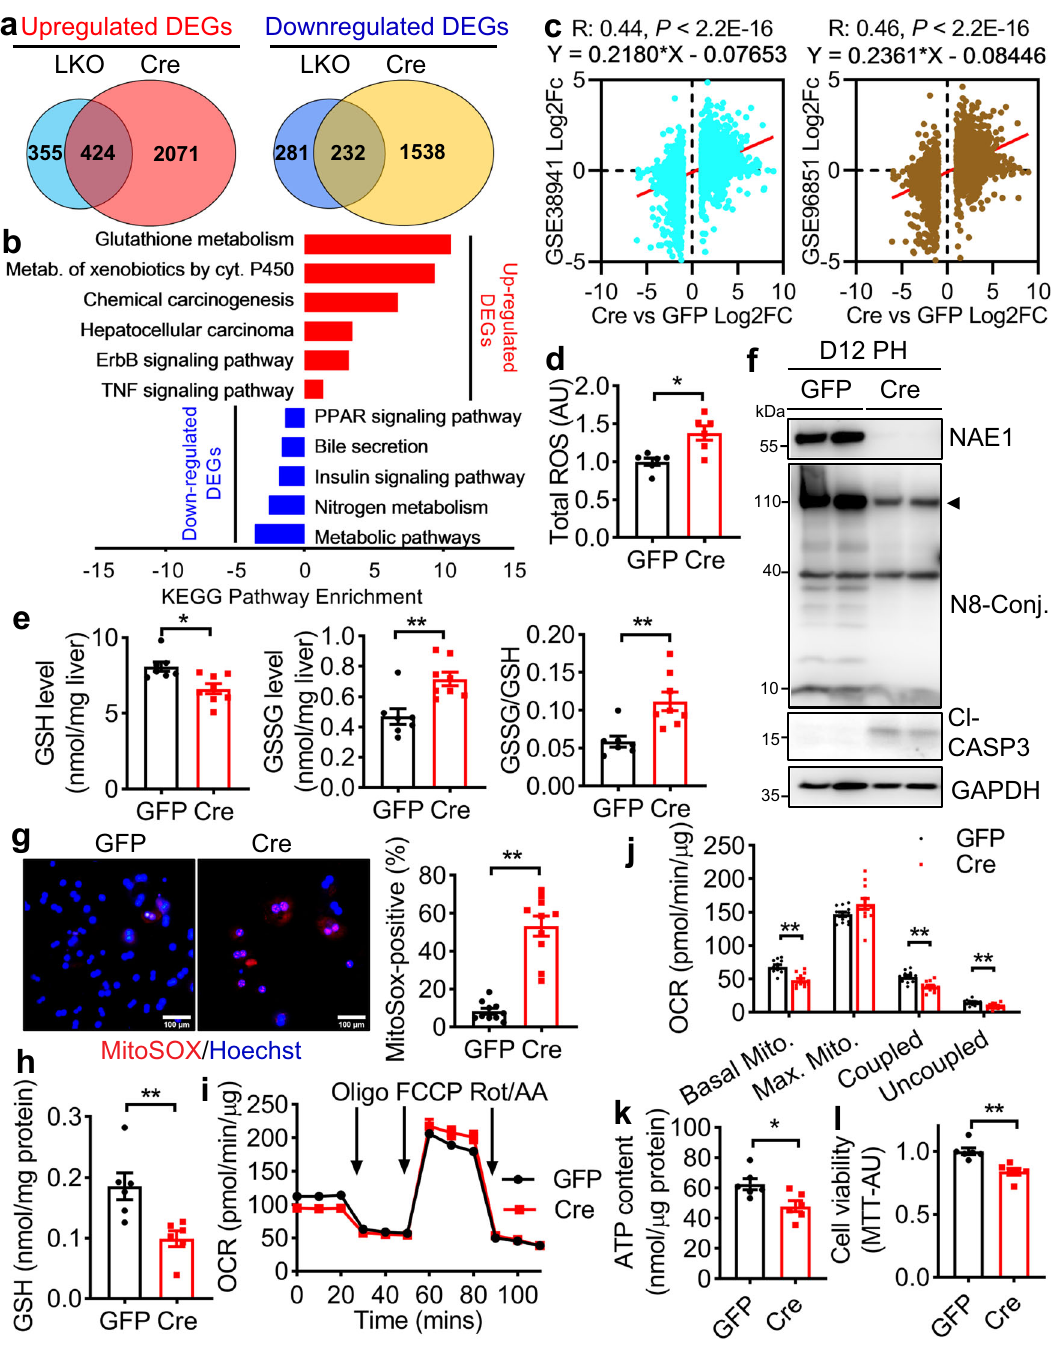
Fig.4|Hepatocyte-speci fi cneddylationde fi